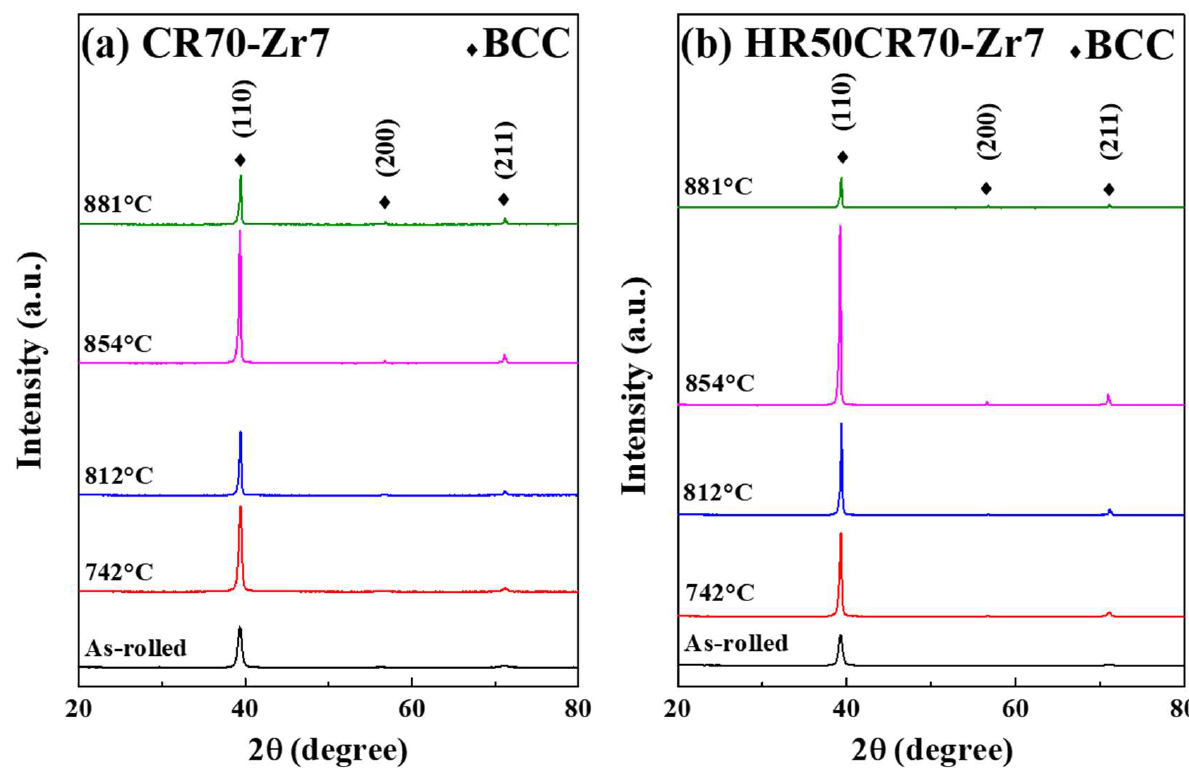
Figure 5. The XRD patterns of ( a ) CR70 and ( b ) HR50CR70 Ti 65 (AlCrNbV) 28 Zr 7 MEAs with different annealing temperatures.